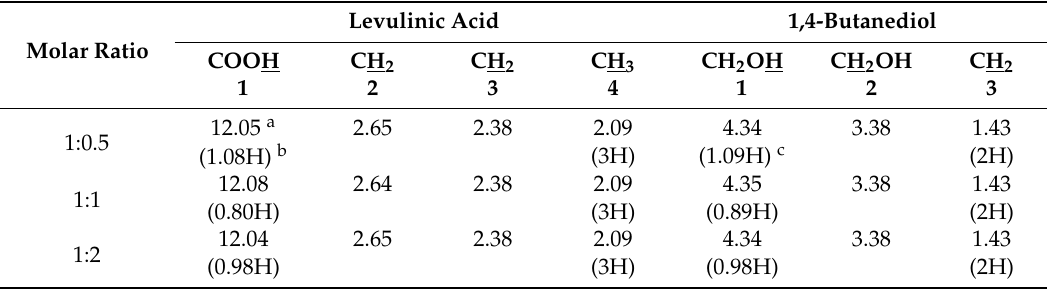
Table 4. Chemical shifts and relative numbers of some protons in the 1 H NMR spectra of La-Buta DESs with different molar ratios (500 MHz, DMSO- d 6 , δ in ppm).